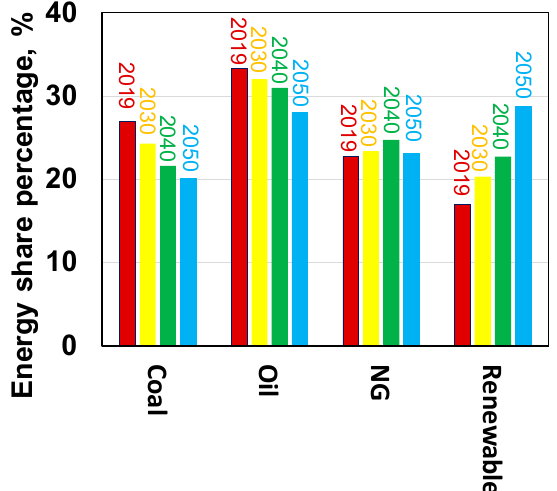
Figure 1. World primary Energy and projection (data from [1]).